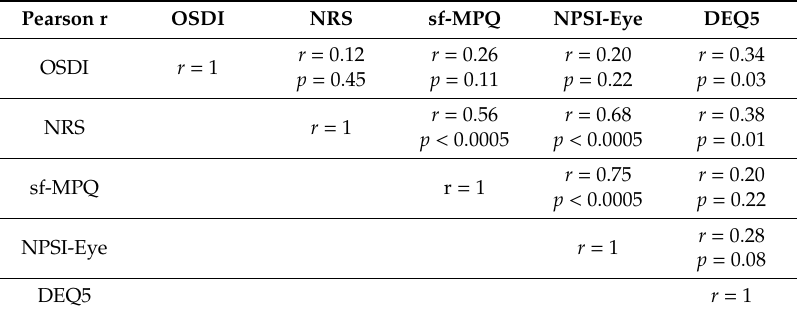
OSDI = Ocular Surface Disease Index; NRS = Numerical Rating System for average ocular pain over one week recall; sf-MPQ = Short Form McGill Pain Questionnaire; NPSI-Eye = Neuropathic Pain Symptom Inventory Modified